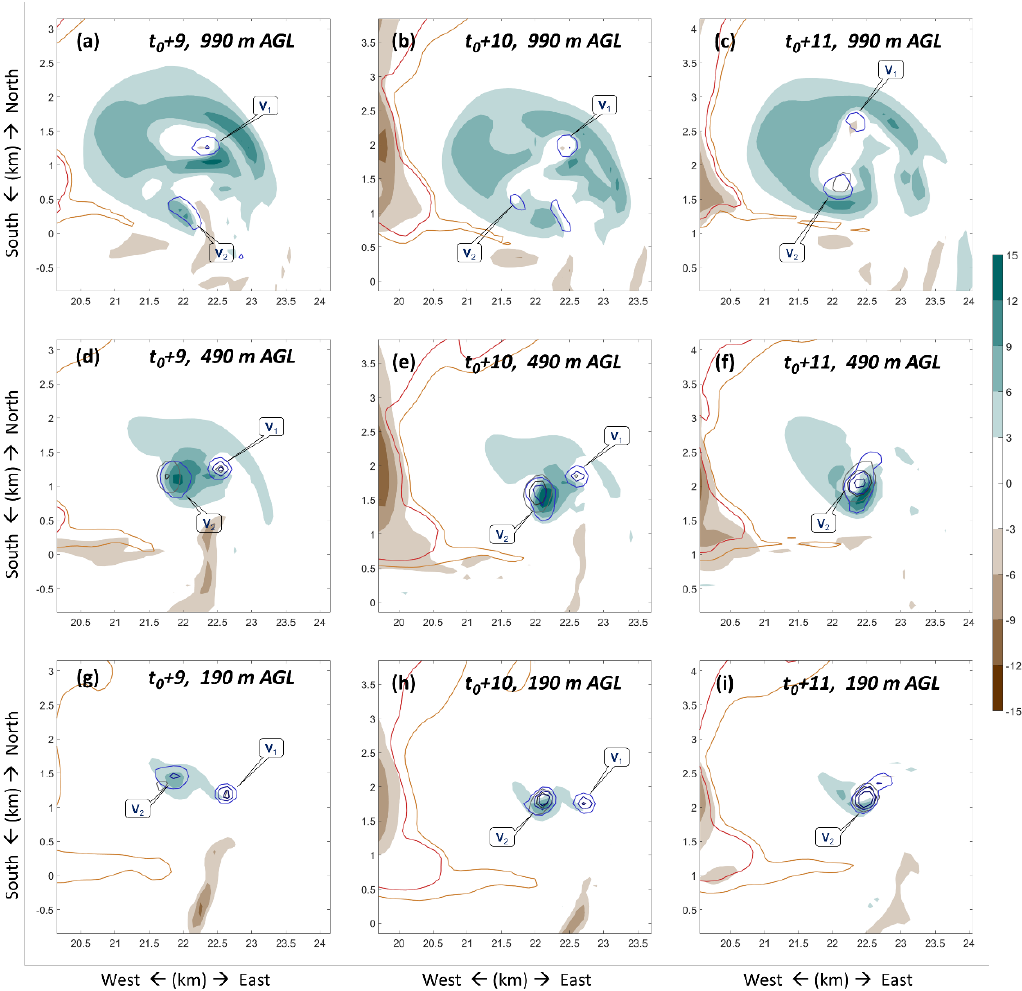
Figure 9. Horizontal cross-section of the simulated supercell and tornado in the first near-surface vorticity replacement during the tornado intensification stage at the height of ( a − c ) 990 m, ( d − f ) 490 m and ( g − i ) 190 m AGL at (left column) t 0 + 9 min, (middle column) t 0 + 10 min and (right column) t 0 + 11 min. Vertical velocity is given by shaded contours. Reflectivity of 40 (50) dBZ is given by orange (red) contours. Vertical vorticity of 0.05, 0.1 and 0.15 s − 1 is given by blue contours. Pressure perturbation of − 1.5 and − 2 hPa is given by dark grey contours. V 1 and V 2 denote the first and second tornadic vortices, respectively.